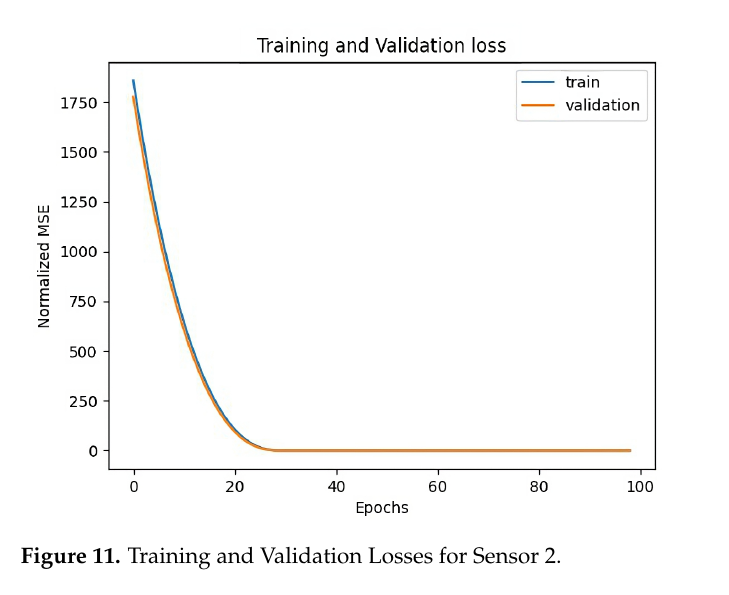
Figure 11. Training and Validation Losses for Sensor 2.